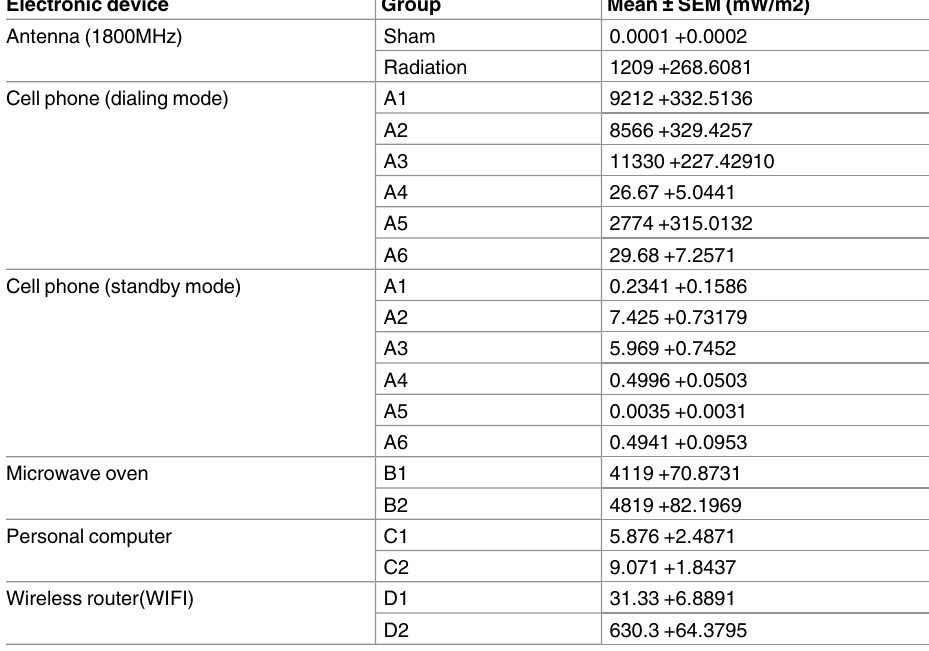
Table 1. Intensity test of microwave radiation for various electronic devices (peak reading XYZ